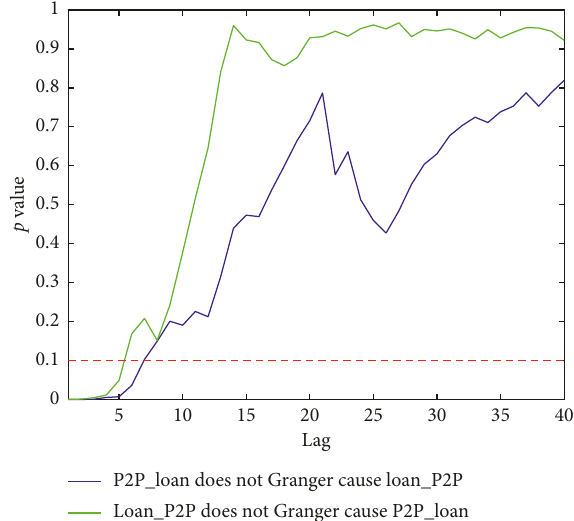
Figure 6: Granger causality test with the new series. The dashed line represents the significance level of 10%.